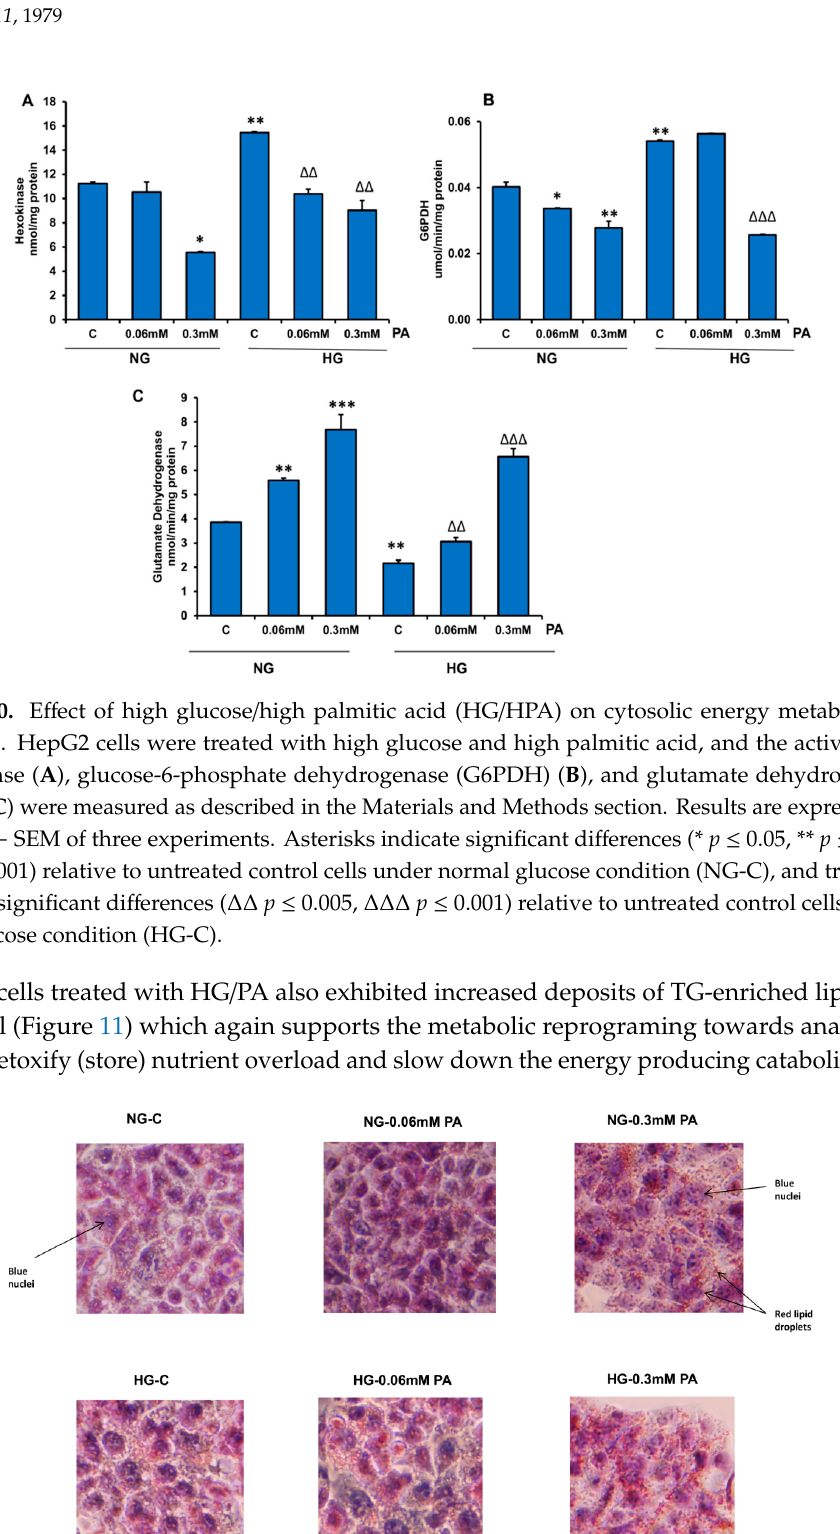
Figure 12. Effect of high glucose/high palmitic acid (HG/HPA) on inflammatory markers. HepG2 cells were treated with different doses of palmitic acid in normal/high glucose media, and inflammatory markers, TNF- α ( A ), IL6 ( B ), and NO levels ( C ) were measured in the media supernatants, as described in the Materials and Methods section. Results are expressed as mean +/ − SEM of three